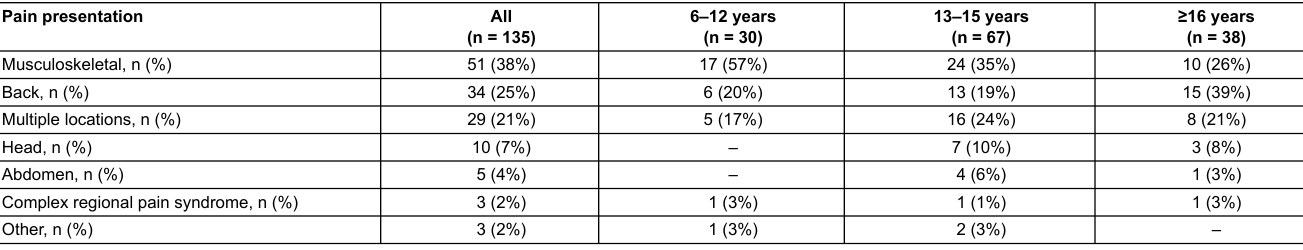
Table 1: Presentations of the pain reported by the patients and their distribution on the different age groups. Pain presentation